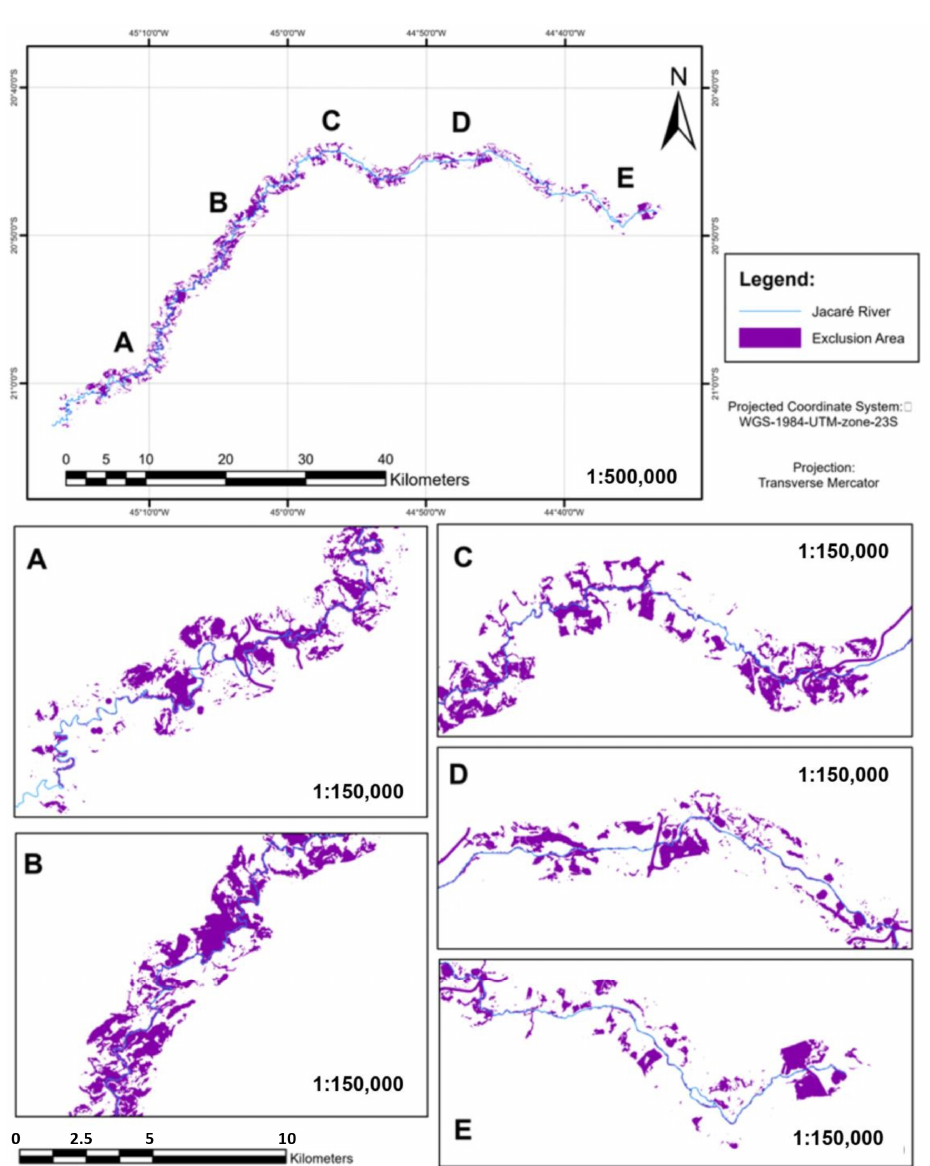
Figure 12. Constraints map. ( A – E ) are the regions with the most significant potential for reforesta- tion